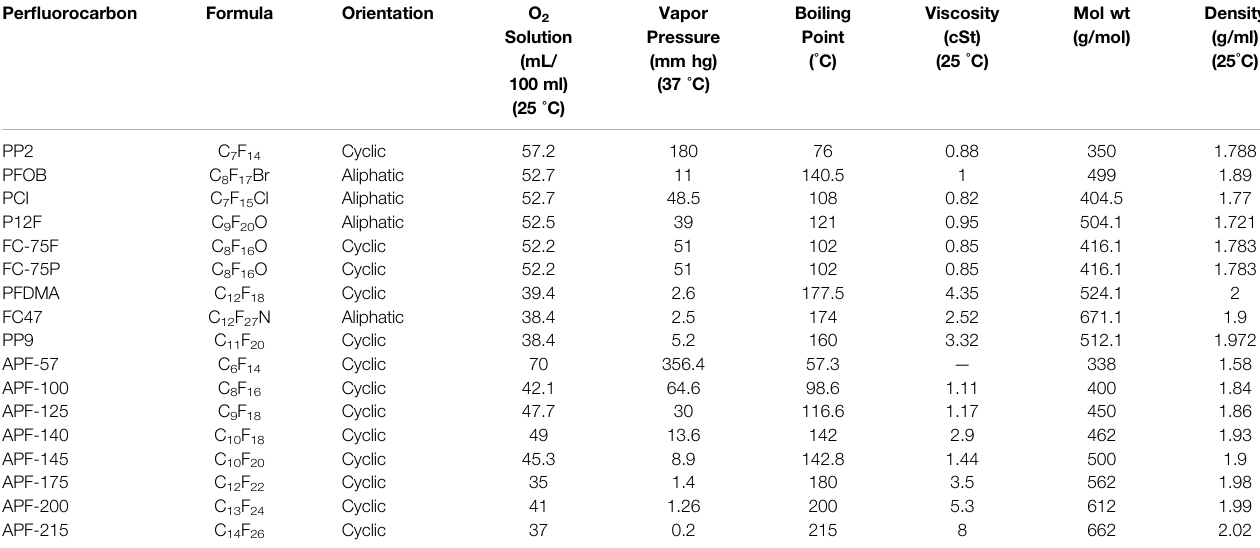
TABLE1| Physiochemicalpro fi leofvariousper fl uorocarbons.ReprintedfromShaffer,T.H.,andWolfson,M.R.(2011). “ LiquidVentilation, ” inFetalandNeonatalPhysiology, 4th Edition, eds: R. Polin, W.W. Fox, and S. Abman (Philadelphia, PA: WB Saunders), 1063 – 1081, with permission from Elsevier. Per fl uorocarbon